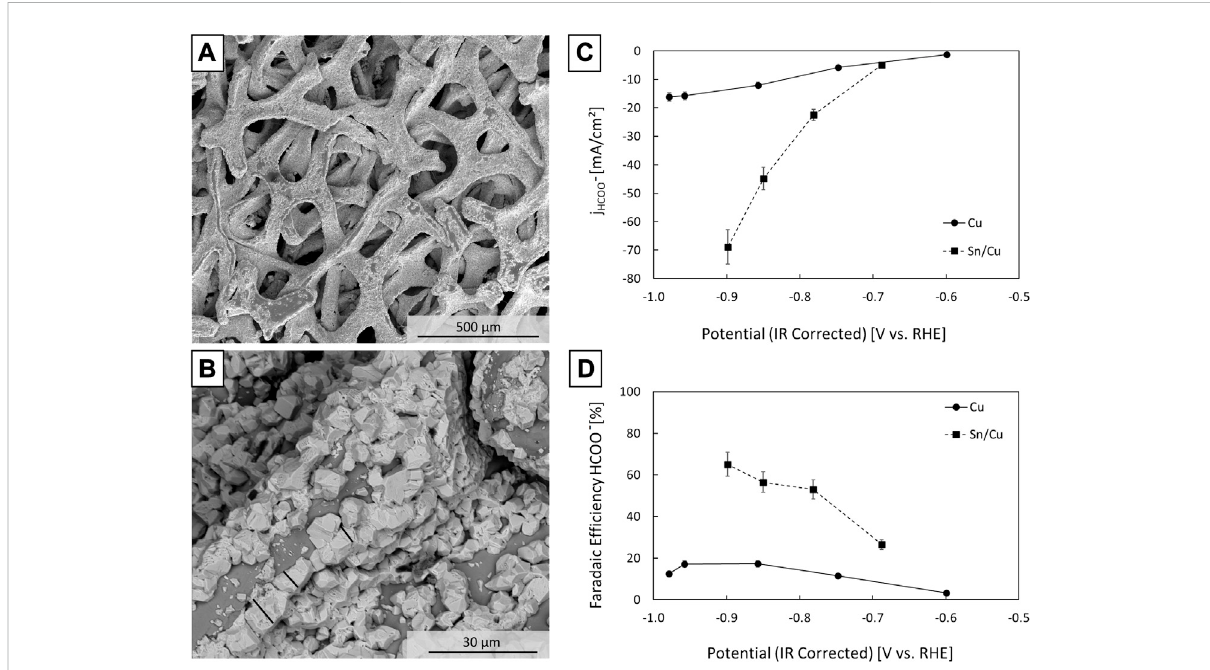
FIGURE 2 SEMimagesoftheSn/Cucathodeelectrocatalyst (A,B) ,partialcurrentdensities (C) andformatefaradaicef fi ciencies (D) againsttheIRcorrected reduction potential in a H-cell setup with CO 2 saturated 0.5 MKHCO 3 catholyte. Formate was quanti fi ed via ion chromatography bysampling atthe end of a 30 min measurement. The error bars correspond to the standard deviation on the ion chromatography